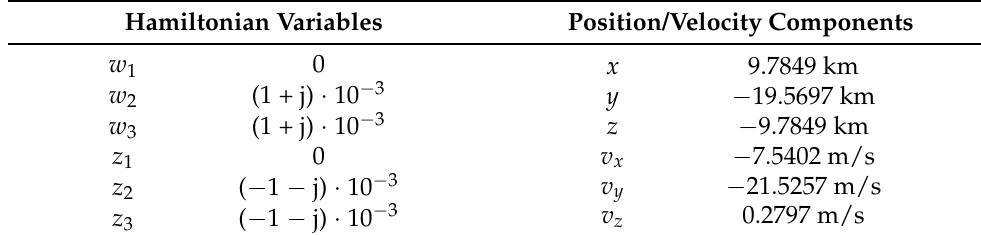
Figure 4. SSO formation: time behavior of z component. Table 5. Mid-inclination LEO formation: initial state of deputy